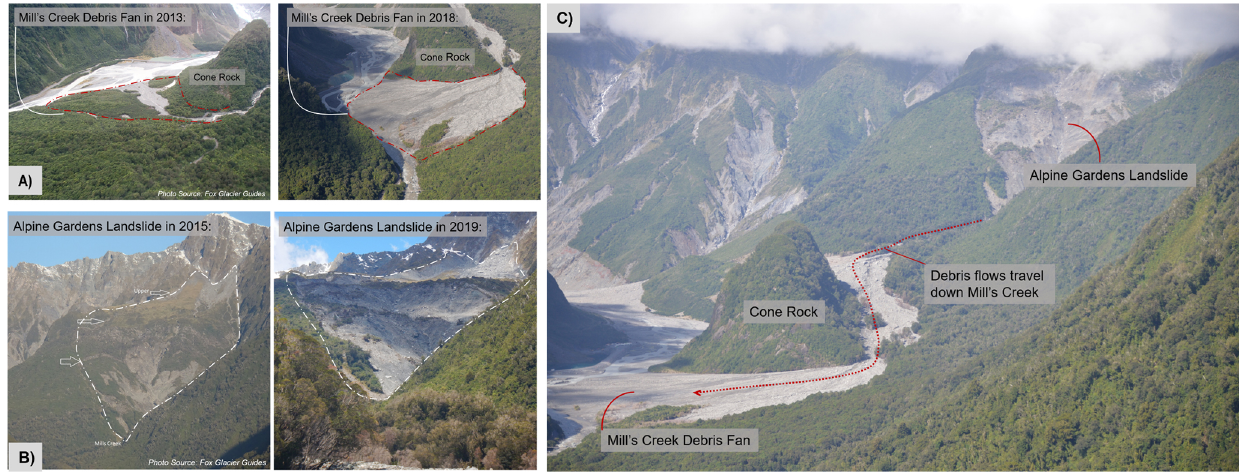
Figure 10. (a, b) Photographs of the evolution of the Mill’s Creek debris fan and Alpine Gardens landslide. (c) The linkage between the Alpine Gardens landslide and the Mill’s Creek debris channel and